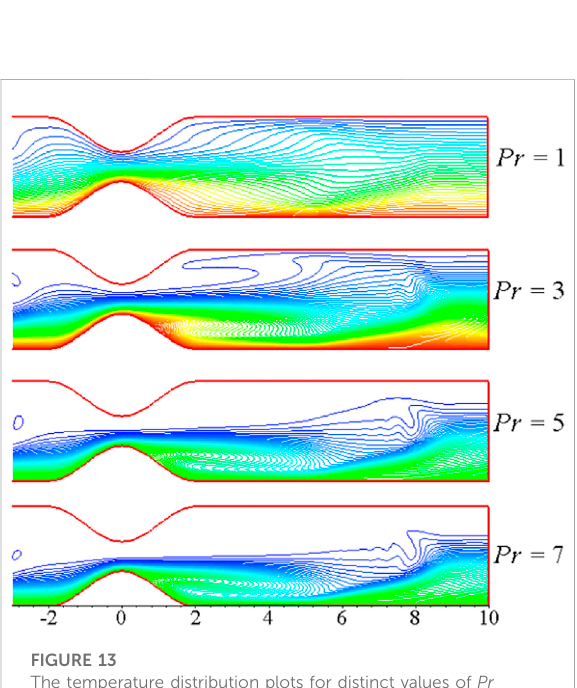
The temperature distribution plots for distinct values of Pr with Re (cid:2) 700 , M (cid:2) 5 , St (cid:2) 0 . 02 , and Rd (cid:2) 0 . 2 for the NF Cu - H 2 O .